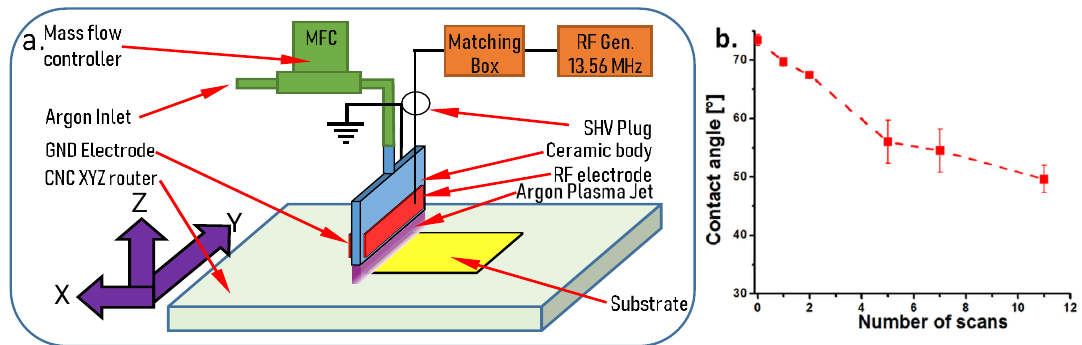
Figure 1. Experimental setup for the DBD plasma treatment of PHB nanocomposite films (substrate) ( a ); contact angle of the nanocomposite films vs. the number of scans ( b ).